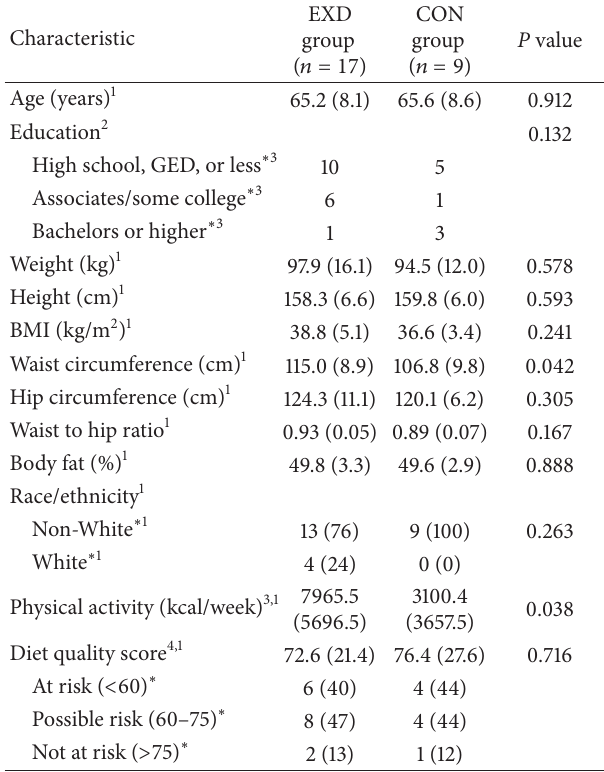
Table 1: Baseline characteristics of the experimental group (EXD) and of the control group